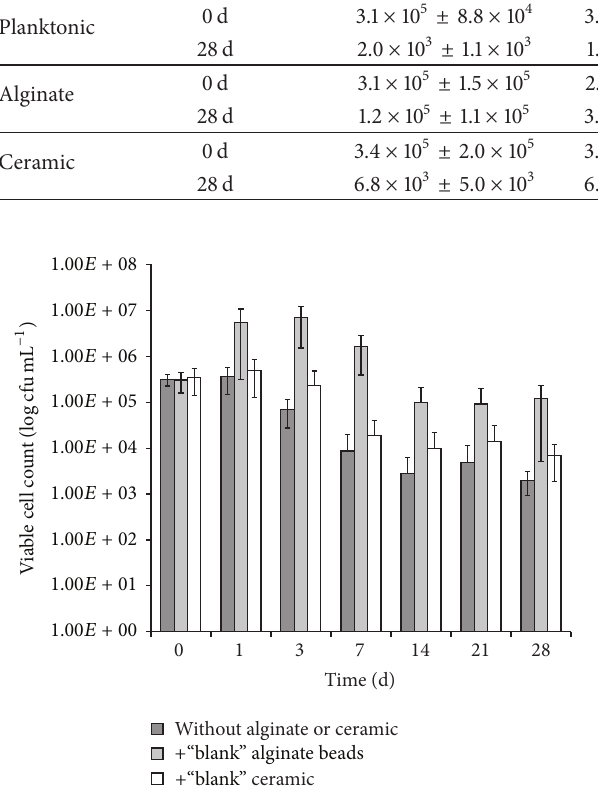
Figure 2: Logarithmic presentation of V. anguillarum viable cell counts [cfu mL −1 ] in the presence of empty alginate beads and ceramic tiles, respectively, and without any material (control). The initial concentration of V. anguillarum is the same in both experimental setups ( ∼ 10 5 cfu mL −1 ; see Table 2).